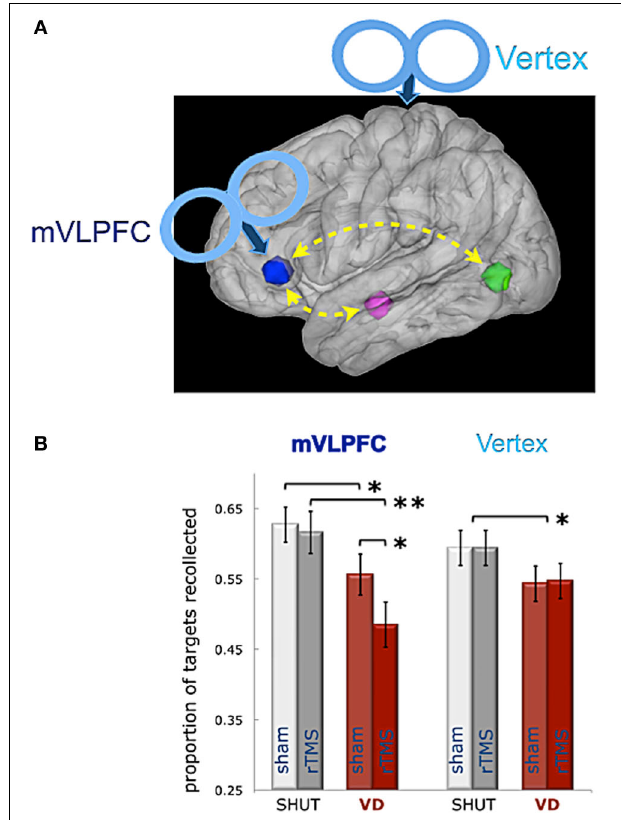
FIGURE 4 | Role of left VLPFC in episodic retrieval during visual distraction. A schematic illustration (A) shows the rTMS targets located on a sagittal rendering of the MNI template brain, including the mVLPFC ROI (blue) functionally connected in a recollection network with the left hippocampus (magenta) and lateral occipital cortex (green), as represented in Wais et al. (2012a). (B) The mean proportion of targets given the correct count is shown in each experiment by condition (SHUT, VD) after sham or actual rTMS treatment. Results show an interaction of actual rTMS on episodic retrieval during visual distraction after VLPFC treatment, but not after Vertex treatment. Error bars represent the standard error of the mean; ∗∗ indicates a difference between means p < 0 . 005; and ∗ indicates a difference between means p < 0 .